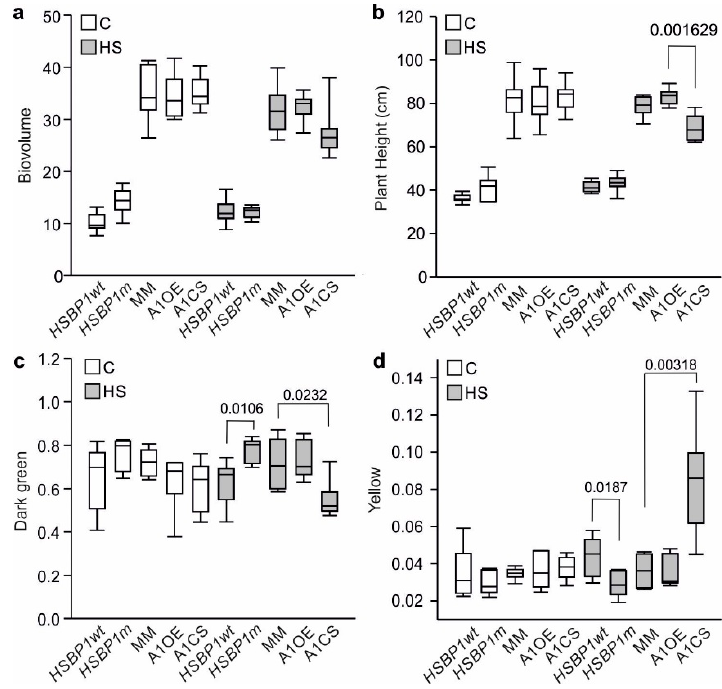
Figure 5. Physiological parameters of control and heat-stressed tomato plants. ( a ) Biovolume, ( b ) Plant height, ( c ) Dark green, and ( d ) Yellow color of SlHSBP1wt , SlHSBP1m , Moneymaker (MM), A1OE, and A1CS plants kept either under control conditions (25 °C; C) for 4 days or exposed to 1 hour of heat shock (HS) at 39 °C every day. Measurements were conducted by a LemnaTec Scanalyzer 3D System. Box plots show the distribution of measurements from eight plants for each parameter as well as the median and the upper and lower quartiles. Statistical differences ( p < 0.05) based on pairwise comparisons by Student’s t-test of the mutant or transgenic plants with SlHSBP1wt or Moneymaker, respectively, are indicated on top of the plots.